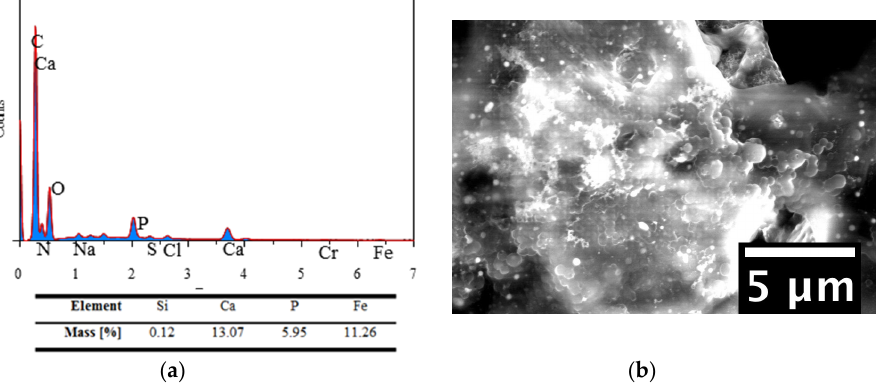
Figure 9. EDS-spectrum ( a ) and the corresponding ESEM image ( b ) of a selected area of Cu-doped 45S5 BG/zein coating surface.